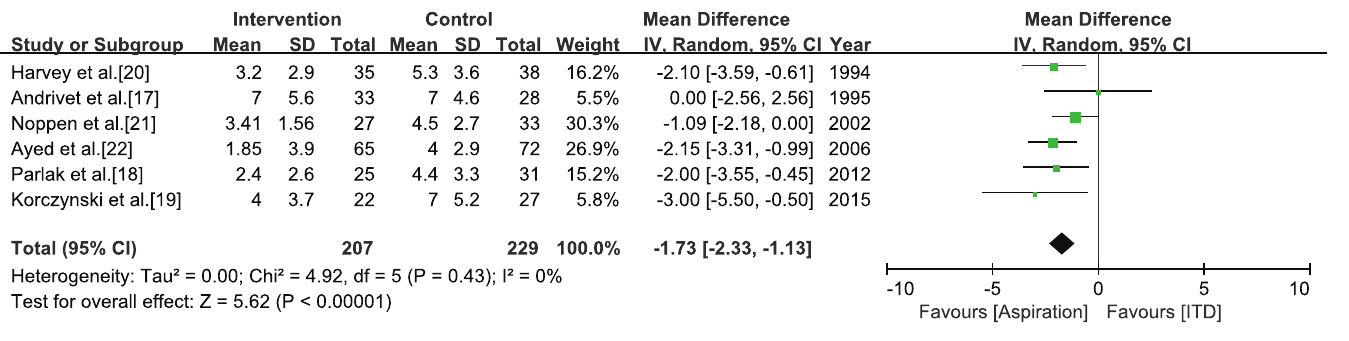
Fig 6. Meta-analysis of the hospital stay associated with aspiration versus intercostal tube drainage.